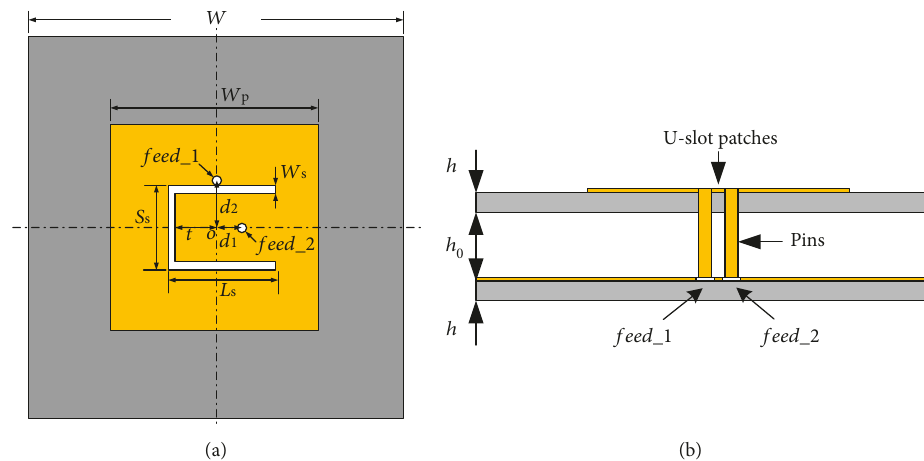
Figure 1: Structures of the antenna element. (a) Geometry of the antenna element. (b) Side view of the antenna element. Dimensions of the antenna element (unit: mm): W = 95 , W p = 50 5 , L s = 21 , S s = 20 , W s = 1 , d 1 = 1 8 , d 2 = 10 2 , t = 6 75 , h = 1 016 , and h 0 = 4 mm